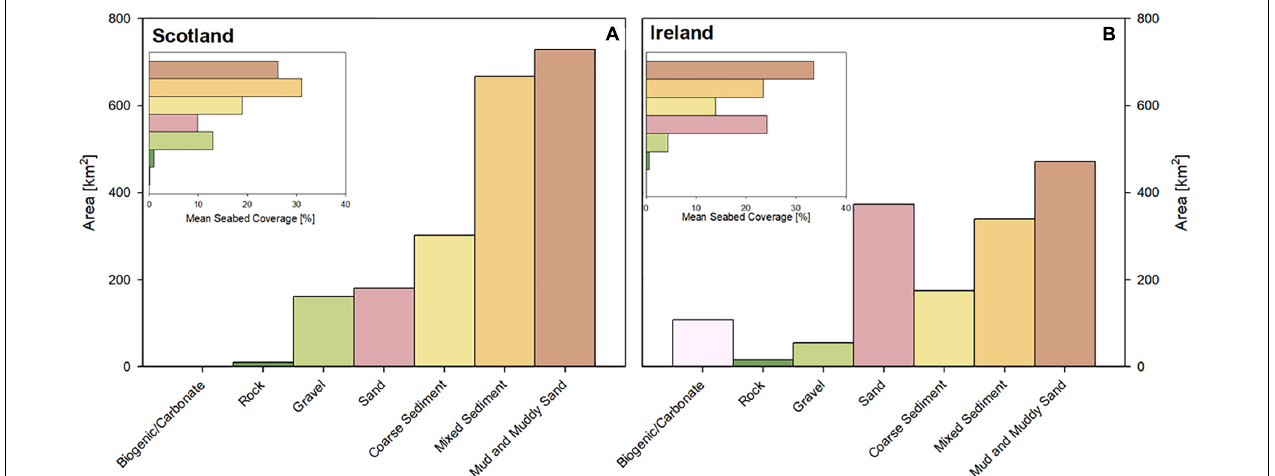
FIGURE 7 | Areal extent of the different sediment types across (A) Scotland and (B) Ireland. Inset: Mean seabed coverage for Scotland and